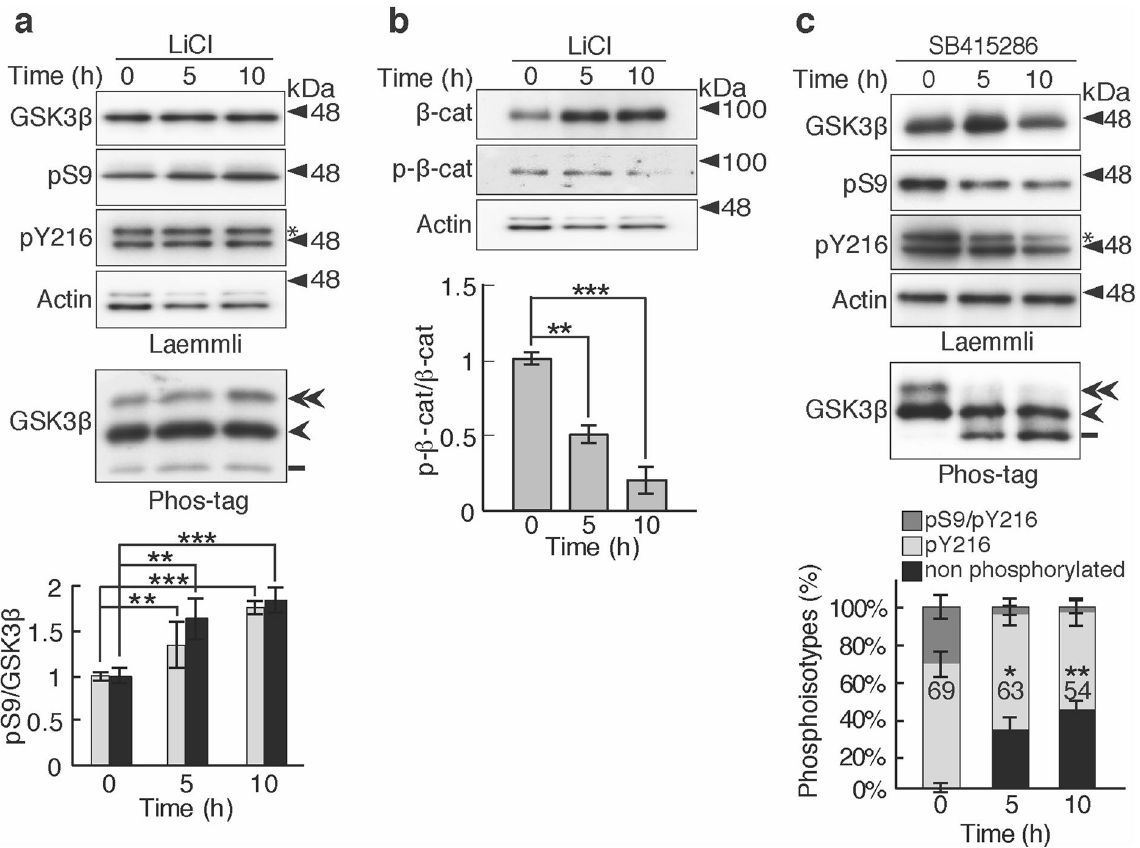
Figure 3. Effects of LiCl and SB415286 on the phosphorylation states of GSK3 β . ( a ) Effects of LiCl on the phosphorylation states of GSK3 β . CHO-K1 cells were treated with 10 mM LiCl for 5 or 10 h and the resulting cell extracts were subjected to Laemmli’s and Phos-tag SDS-PAGE, followed by immunoblotting with the indicated antibodies. An asterisk in the pY216 blot indicates GSK3 α . In Phos-tag (bottom), the double- arrowhead represents Ser9/Tyr216-phosphorylated GSK3 β , the arrowhead represents Tyr216-phosphorylated GSK3 β , and the bar represents nonphosphorylated GSK3 β . Quantification of phospho-Ser9 was shown in the lower graph; gray represents the data from Laemmli and black represents the data from Phos-tag SDS-PAGE (means ± s.e.m. n = 6, ** p < 0.01, *** p < 0.001, one-way ANOVA). ( b ) Phosphorylation of β -Catenin in CHO-K1 cells treated with LiCl as in ( a ). The CHO-K1 cell extracts were immunoblotted with anti- β -Catenin or anti- phospho- β -Catenin. Actin was the loading control, the same as shown in ( a ). The ratio of phospho- β - Catenin to total β -Catenin was quantified and expressed against that of the control at 0 h (means ± s.e.m. n = 6, *** p < 0.001, one-way ANOVA). ( c ) Effects of SB415286 on the phosphorylation states of GSK3 β . CHO-K1 cell extracts treated with 20 μ M SB415286 for 5 or 10 h were subjected to Laemmli’s (upper four panels) and Phos- tag (bottom) SDS-PAGE, followed by immunoblotting with the indicated antibodies. An asterisk in the pY216 blot indicates GSK3 α . In Phos-tag, the phosphoisotypes are indicated as in ( a ) and are quantified: the upper dark gray section represents phospho-Ser9/phospho-Tyr216, the middle light gray section represents phospho- Tyr216, and the lower black section represents nonphosphorylated GSK3 β . The percentages of phospho-Tyr216 are indicated (means ± s.e.m. n = 6, * p < 0.05, ** p < 0.01, one-way ANOVA). Uncropped immunoblots after Laemmli’s and Phos-tag SDS-PAGE are provided in Supplementary Fig.